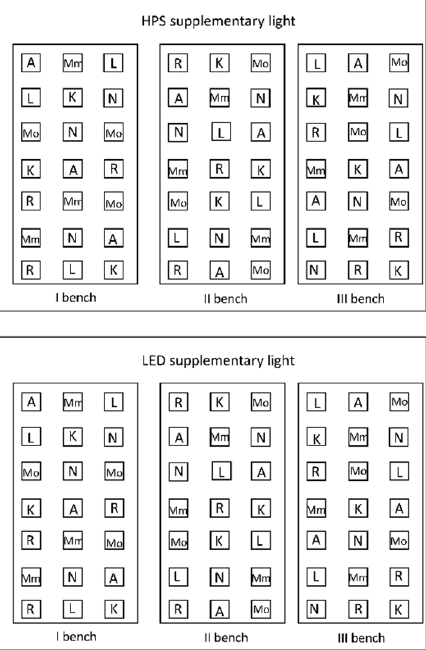
Figure 5. Experimental layout. Tomato plants (7 genotypes) grown in two adjacent greenhouse compartments of each 60 m 2 with different supplementary light technologies (HPS vs. LED). A– Ailsa Craig; K–Kentucky Beefsteak; L–LA1578; Mm–Moneymaker; Mo–Momotaro; N–Nunhems- FM001; R–Rutgers. The plants were interspaced by other tomato plants (that were not evaluated